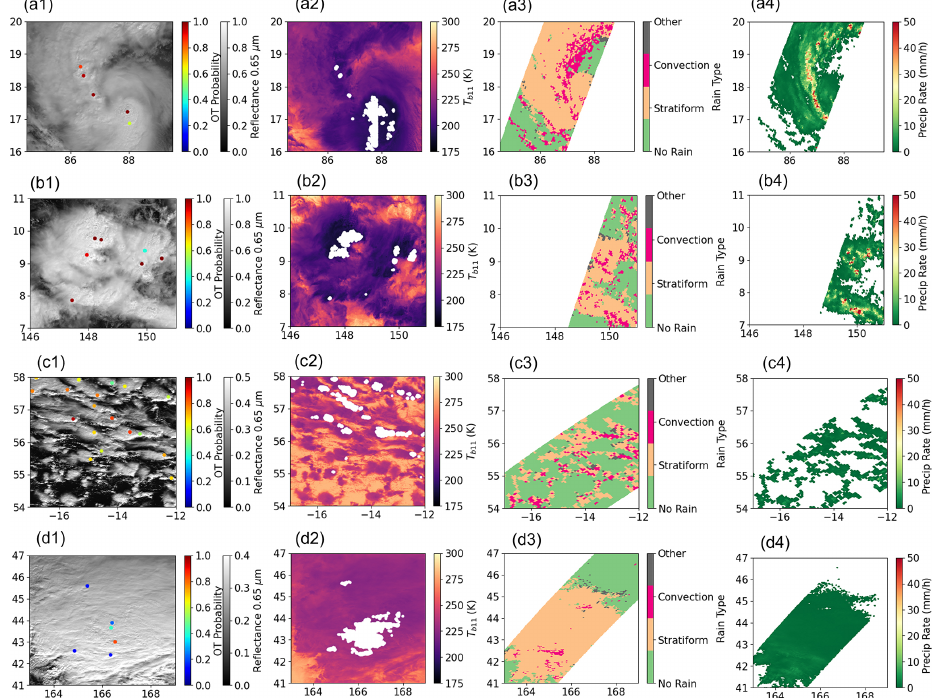
Figure 7. Four selected cloud systems with OTs detected by our IR algorithm. The first column shows the reflectance at 0.65µm (dots indicate OT probability), and the second column shows the brightness temperature at 11µm (white dots indicate pixels colder than tropopause temperature and having positive WV-IRW-BTD). Columns 3 and 4 represent the rain type and precipitation rate from GPM, respectively. Case 1 (a1–a4) is for the tropical cyclone over the Bay of Bengal on 8 December 2019, case 2 (b1–b4) is for a mesoscale convective system over the east of the Philippines on 3 December 2019, case 3 (c1–c4; 10 March 2019 over the North Atlantic Ocean) is for a shallow post-frontal convection, and case 4 (d1–d4; 15 December 2018 over the North Pacific Ocean) is for the cloud system in the midlatitude